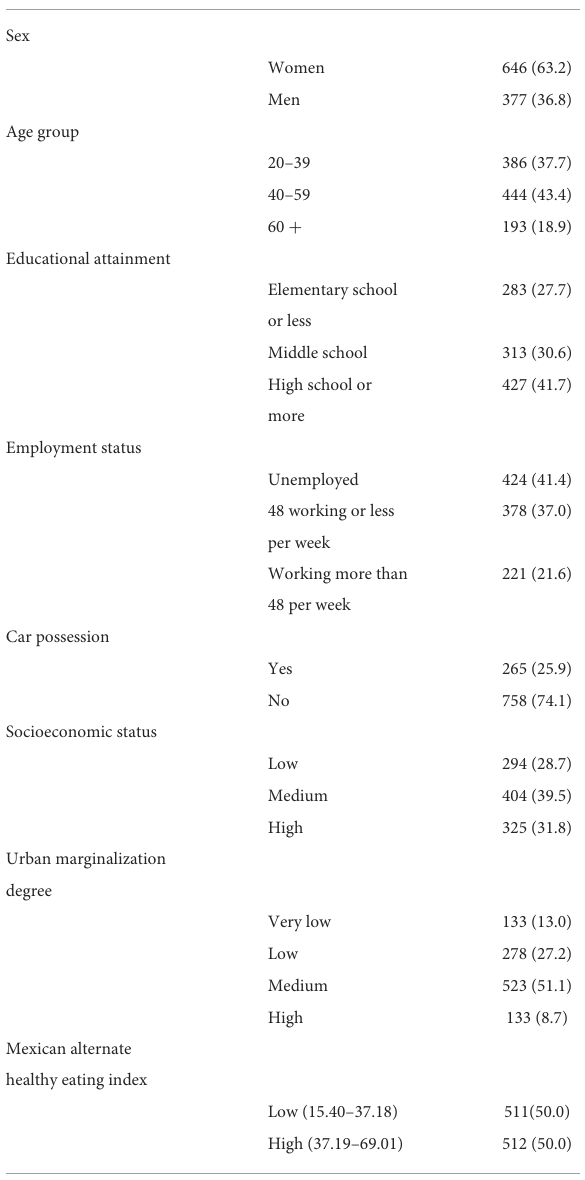
TABLE 1 Sociodemographic characteristics of study participants.